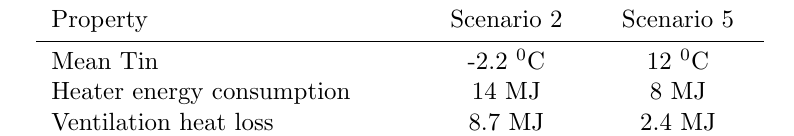
Table 4: Assessment of Scenario 2 and Scenario 5 with respect to heat recovery ventilation